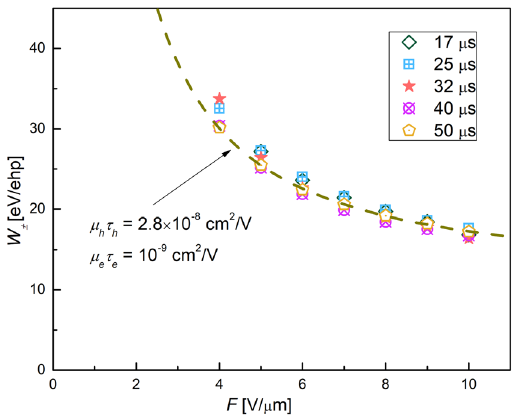
Figure 6. Measured values of W ± are plotted as a function of F for different τ s